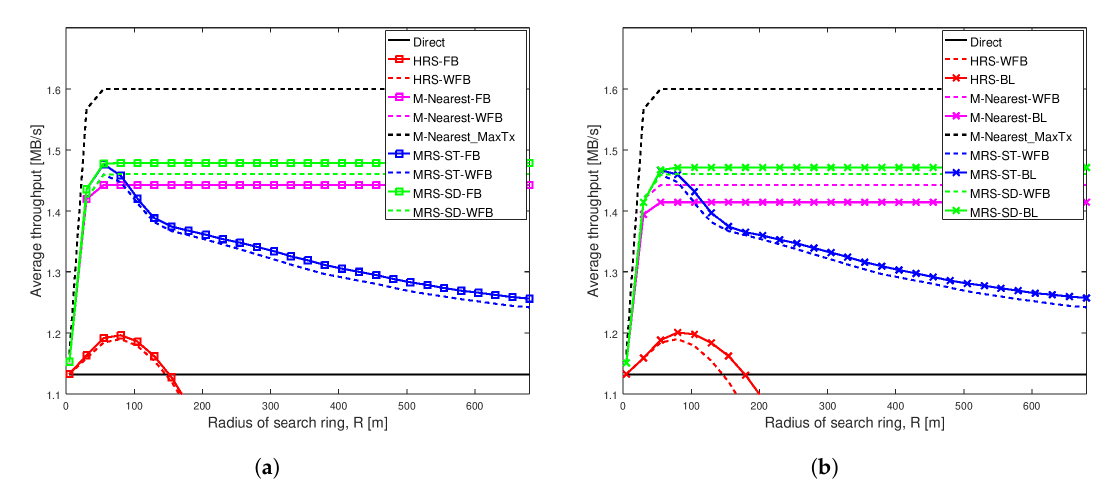
Figure A3. Average throughput of different schemes when Shape = 1.1 and Scale = 0.1 in a network having width of 1000 m. ( a ) Different battery power levels not considered in relay selection; ( b ) Different battery power levels considered in relay selection.